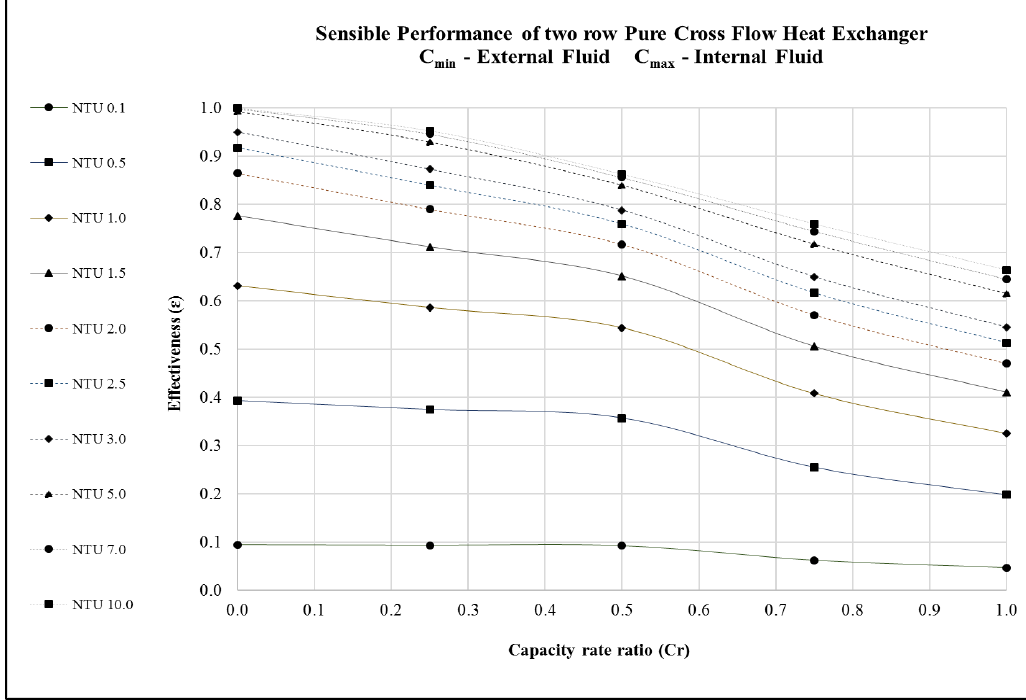
Figure 4. Performance predictions of a 2-row pure cross flow heat exchanger undergoing sensible heat transfer.